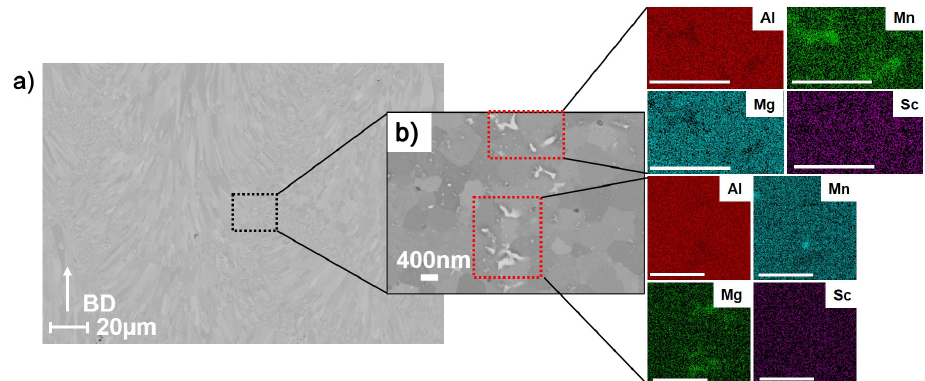
Figure 9. ( a ) Electron microscopy images for peak-aged condition (598 K for 4 h). ( b ) Inset image shows a magnified section where EDX maps were taken and grain boundary precipitation can be observed. The EDX maps show Al, Mn, Mg and Sc as identified elements. It is seen that Mn-enriched precipitates are found at grain boundaries, with some of them possibly rich in Mg. The scale bar for EDS images represents 1 µm length.